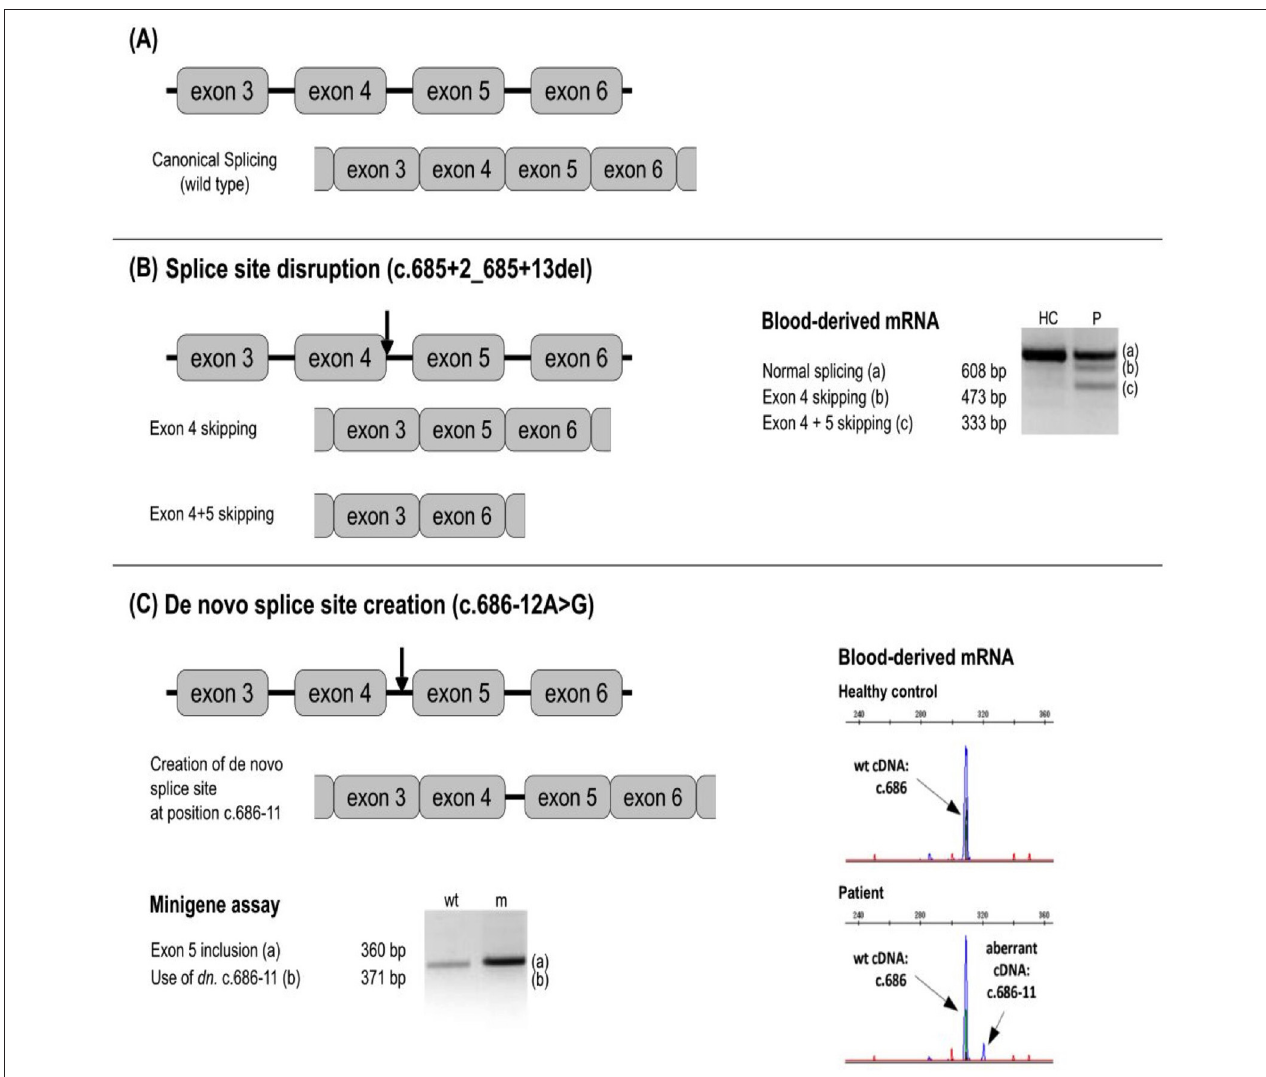
FIGURE 4 | Examples of a splicing variant analysis. Next to the respective splicing defect schemes, the results of blood-derived patients’ RNA analysis and/or minigen analysis are shown as RT-PCR amplicons visualized by agarose or capillary gel electrophoresis. Arrows depict approximate location of the analyzed variants. (A) No splicing defect. (B) Splice site disruption. The variant c.685 + 2_685 + 13del leads to the formation of new transcripts with exon 4, and exons 4 + 5 skipped. (C) New splice site creation. The variant at c.686-12 leads to the splice site gain at the position c.686-11 and the inclusion of intron 4 in the transcript. In silico prediction is helpful to identify splicing-affecting mutations prior to functional assays